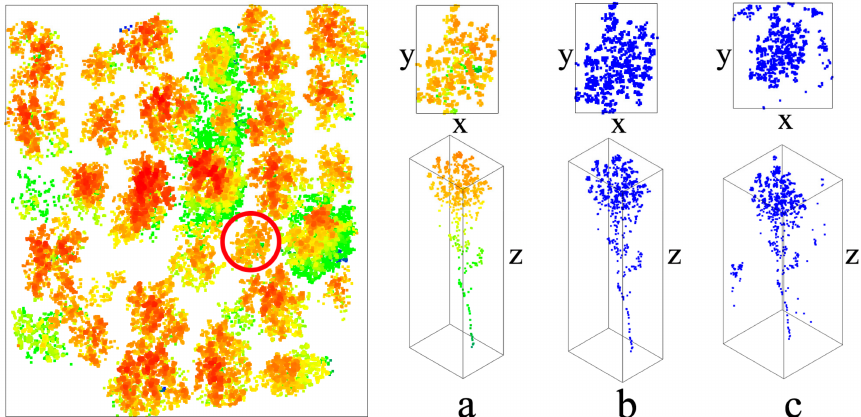
Figure 8. Evaluation parameters to quantify the process of refining results. The left part is the sample plot used for example (Y16-2). The right part is an individual tree example extracted manually ( a ), segmentation with the refining process ( b ), and without the refining process ( c ). The values x and y are the two sides of the horizontal projection of the tree, and z is the vertical range of the